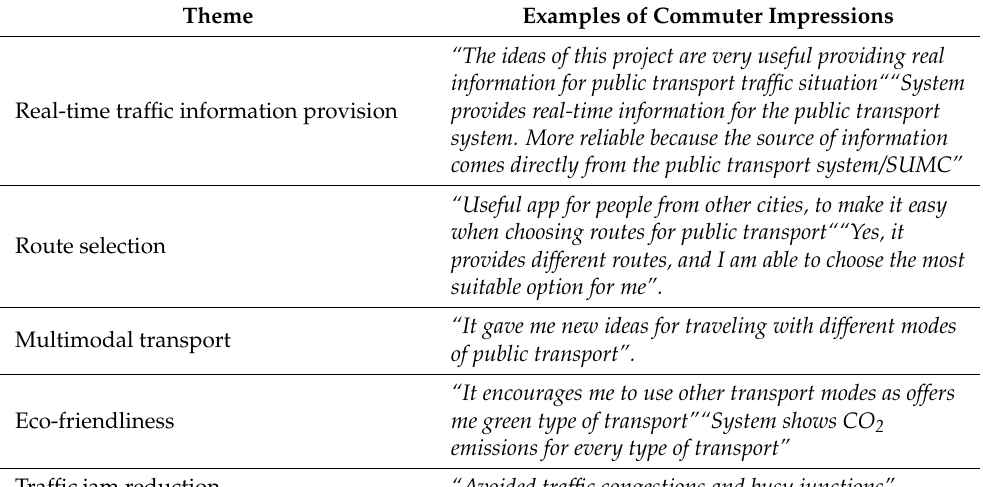
Table 4. Commuters’ impressions about the multimodal recommender system. SUMC, Sofia Urban Mobility Center.